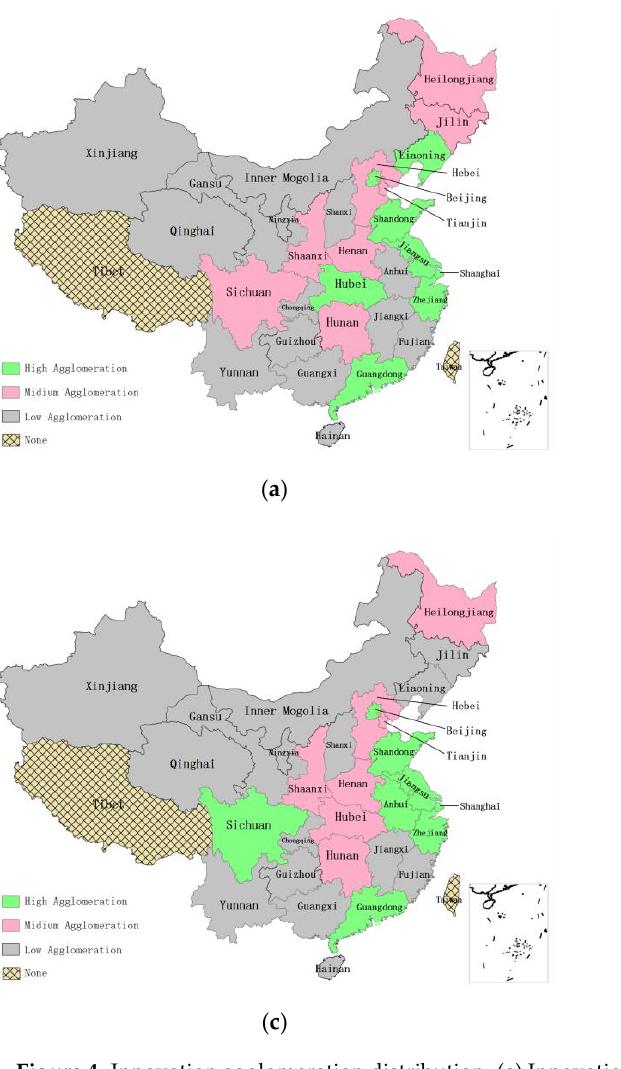
Figure 4. Innovation agglomeration distribution. ( a ) Innovation agglomeration in 2006. ( b ) InnovaTable 2010. ( c ) Innovation agglomeration in 2014. ( d ) Innovation agglomeration in 2018.